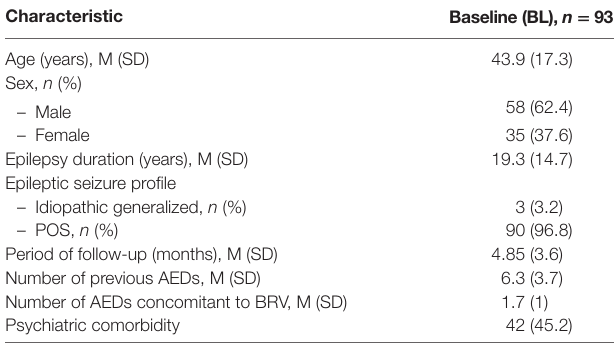
TaBle 1 | Patients’